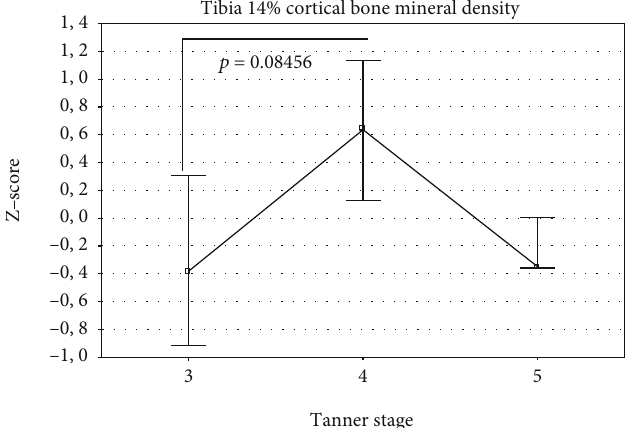
Figure 1: Z -scores for tibia 14% cortical bone mineral density in girls by Tanner stage (median and Q1-Q3). Overall Kruskal-Wallis ANOVA p is 0.0462; however, post-test does not reach signi fi cance level; the lowest p value is presented.